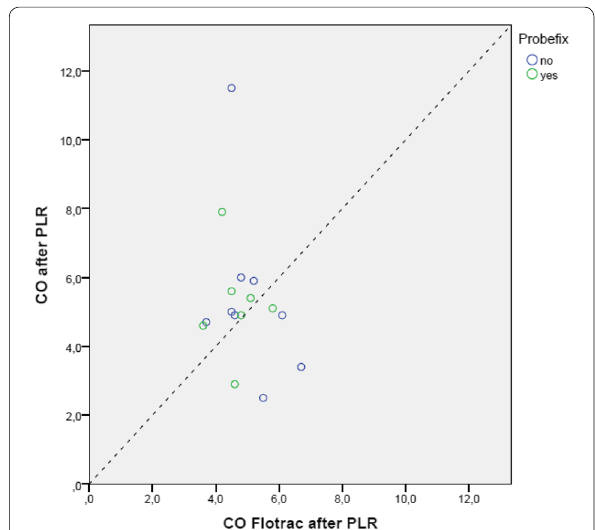
Fig. 7 Scatter plot transthoracic echo (TTE) cardiac output (CO) vs. Flotrac with (green points) and without the use of Probefix (blue points) after passive leg raising